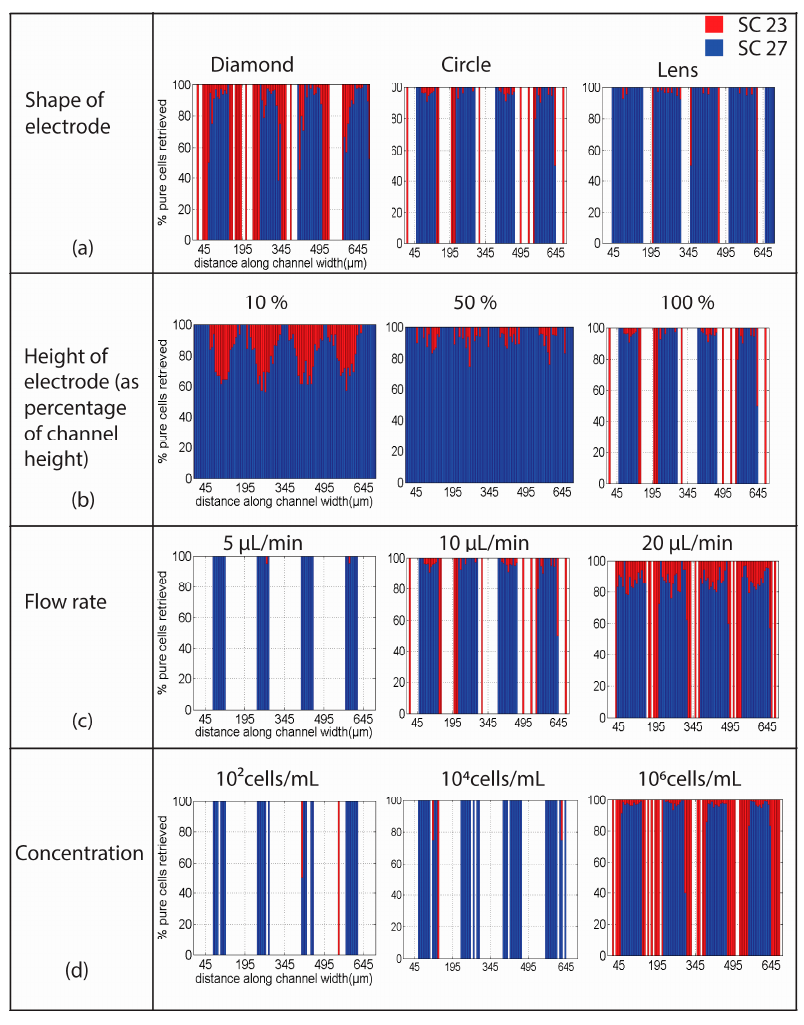
Figure 4. The percentage of SC23 and SC27 retrieved in different conditions considered in the numerical simulations. The stacked histogram in y -axis shows the percentage of SC23 and SC27 streams retrieved at different channel locations (from 0 to 700 µm). The x -axis in each case denotes the distance along the channel width and the grid points at 45, 195, 345, 495 and 645 µm mark the position of the center of each electrode in the channel. ( a ) The impact of electrode cross-section on cell separation; ( b ) Impact of electrode height relative to the channel. The purity of the streams increases with the increase in electrode height; ( c ) Impact of flow rate. 100% pure streams of SC23 cells can be obtained linearly to the electrodes as the flow rate increases. The purity of SC27 decreases at the same time; ( d ) Impact of cell concentration on the separation efficiency between cell types at 10 µL/min. SC23 cells are trapped at low concentrations and are not received, the array becomes saturated at high cell concentrations and SC23 streams start appearing collinear with the electrodes.